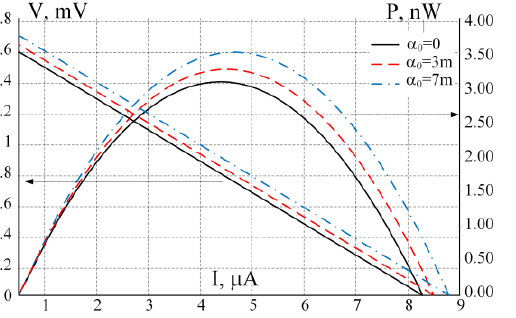
Figure 12. V-I and P-I output characteristics of a single couple shown in Figure 11 for various values of thermal coefficient of Seebeck constants for p- and n-types of thermoelectric